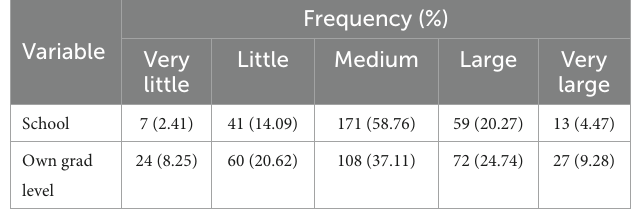
TABLE 3 Extent of challenging behavior.